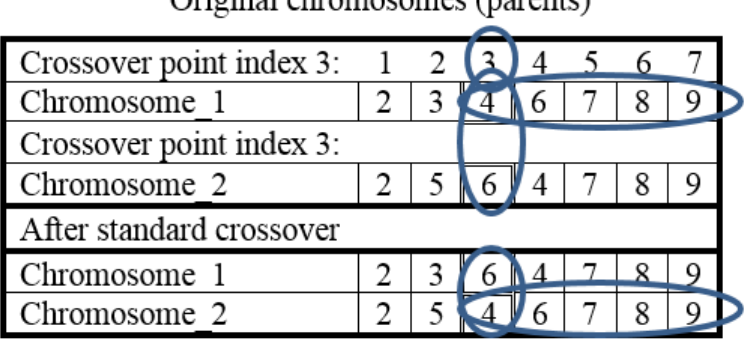
Figure 5. Chromosome intersection samples. 4. Experiment Results and Discussion In this section, three experiments are presented. The experiments were performed on network topologies with four different sizes. The parameters for each scenario were de- termin ed based on the randomness of the network’s behavior. The network sizes in these experiments were 20, 30, 40, and 50 nodes. The first experiment discovered the routes from the source node to all other nodes as destinations and evaluated the performance of the chromosome intersection method in the proposed algorithm. The second experiment examined the intersection GA-based routing algorithm to find the efficient path based on the multiconstraint’s values from the source node to the specific destination node. The third experiment compared the proposed intersection GA-based routing selec- tion and dynamic source routing (DSR). DSR is one of the common reactive routing algo- rithms in MANET. Thus, it is considered the best in the ad hoc network field. The simulation experiment was performed using ns-2 according to the simulation setup shown in Table 2.